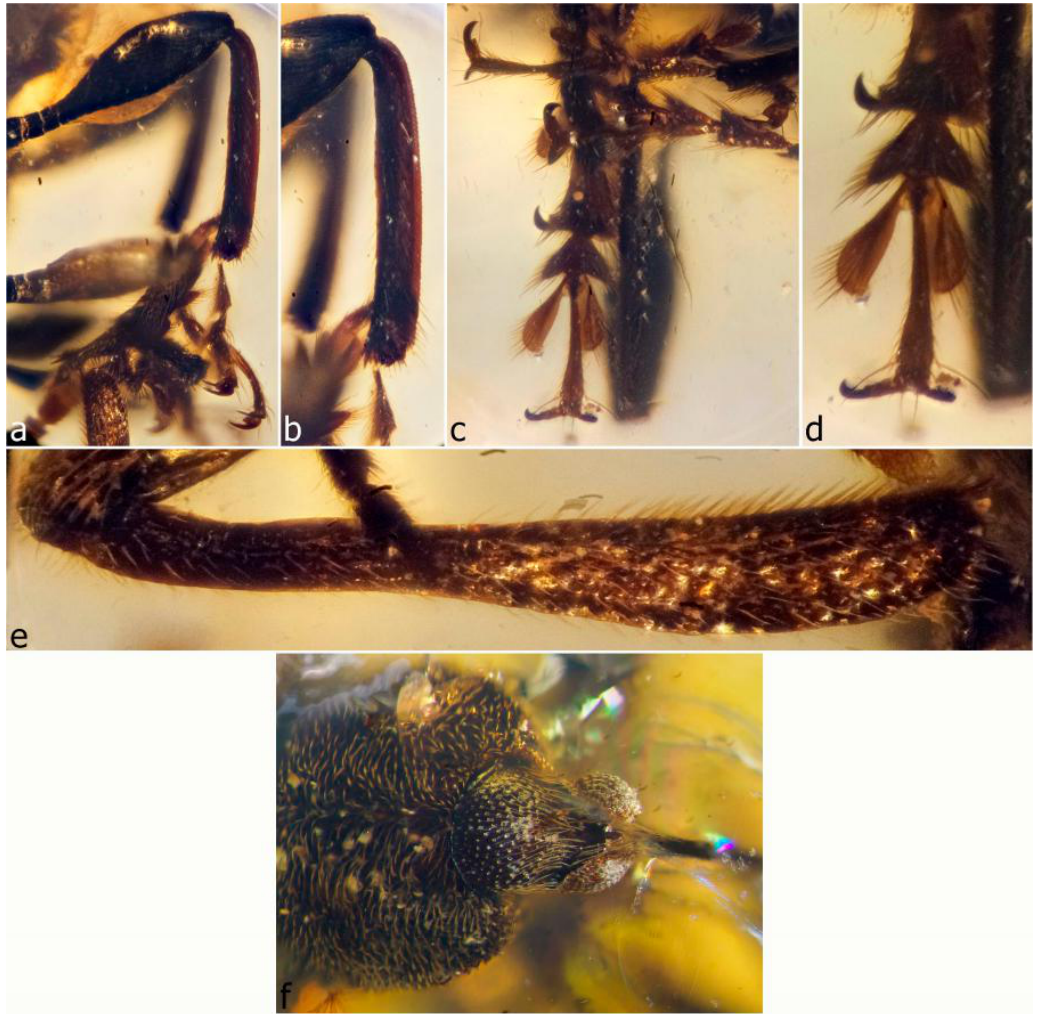
Figure 57. Mekorhamphus gyralommus . Left hindleg, outer side ( a ); detail of left metatibia, outer side ( b ); tarsi, dorsal ( c ); detail of tarsus, dorsal ( d ); right protibia, inner side ( e ); Mekorhamphus gyralommus , holotype, head, dorsal view ( f ).